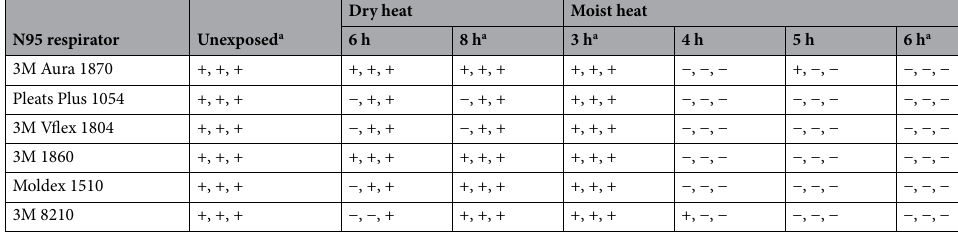
Table 1. Efficacy of heat treatments in decontaminating N95 respirators contaminated with SARS-CoV-2. + viral growth present, − no viral growth present; each +or − sign represents presence/absence of viral growth from a triplicate set of N95 respirator swatches; viral titer in unexposed control coupons range from 4.62 ± 0.1 to 4.44 ± 0.1 log TCID 50 . a Data from three separate